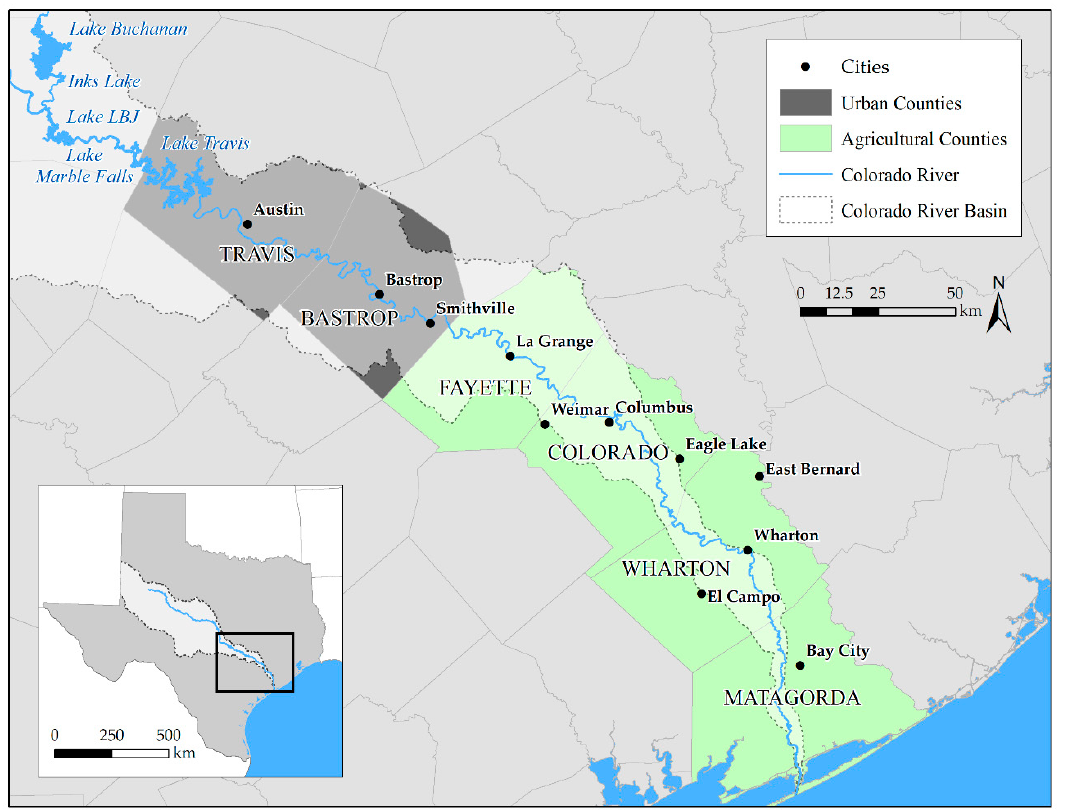
Figure 1. Study area of the lower Colorado River basin in Texas.